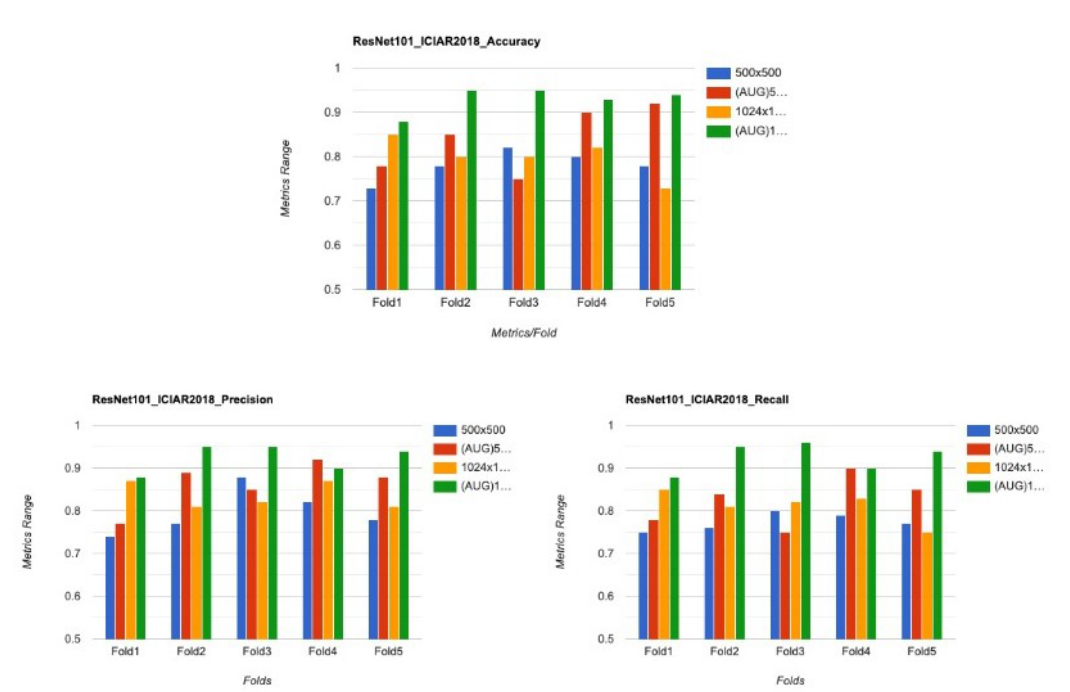
Figure 7. Comparison of the performance metrics ICIAR2018 for different